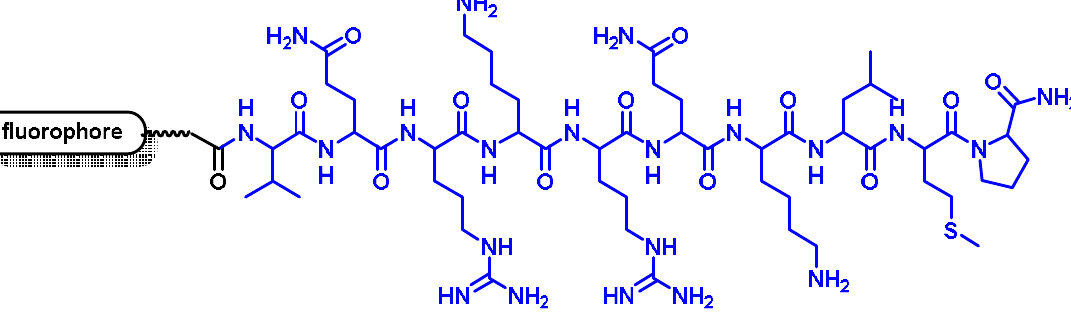
Figure 3. Nucleus-targeted fluorescent probe design strategy based on the NLS group (VQRKRQKLMP).